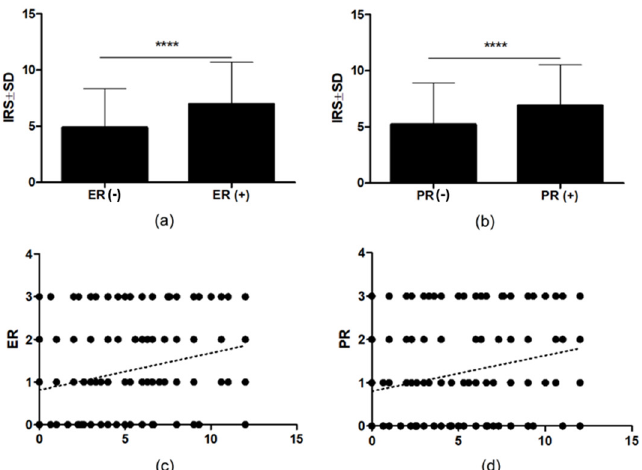
Figure 5. ( a ) ER-positive (ER+) tumors showed a significantly higher level of NUCB2 expression than ER-negative (ER − ) cases (**** p <0.0001). ( b ) PR-positive (PR+) tumors showed a significantly higher level of NUCB2 expression than PR-negative (PR − ) cases (**** p <0.0001). ( c , d ) A significant positive correlation of cytoplasmic expression of NUCB2 with the expression of ER and PR (r = 0.2779, p < 0.0001; r = 0.2552, p < 0.0001).